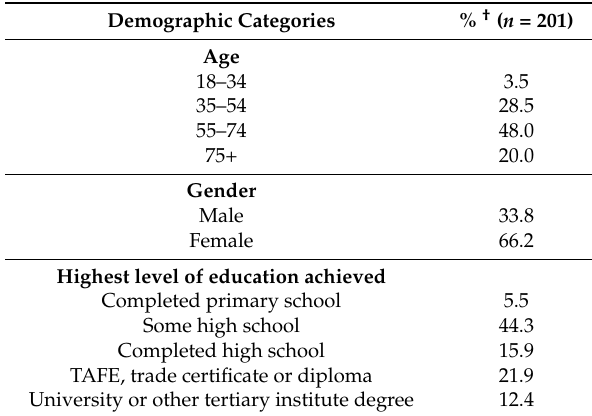
Table 1. Demographic characteristics of